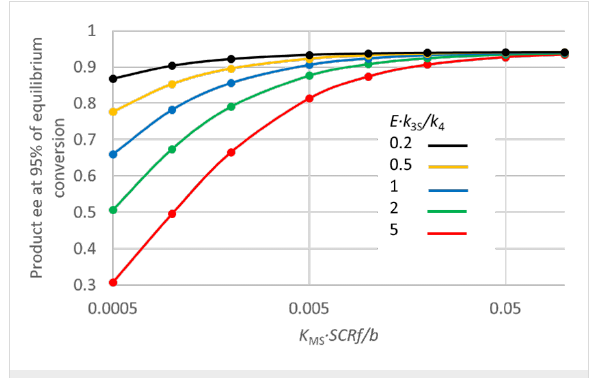
Figure 3: Effects of key enzyme parameters on the fall in product ee during reaction for “ordered, second” kinetics. S 0 = 0.2 M, D = 0.00333 M, Q = 0.00167 M, K eq = 5, E = 39, K MD = 0.001 M, K MS = 0.001 M, k 4 = 1000 s − 1 , k 3R / k 4 = 1, k − 4 / k 1 = 1, k − 2R / k − 1 =